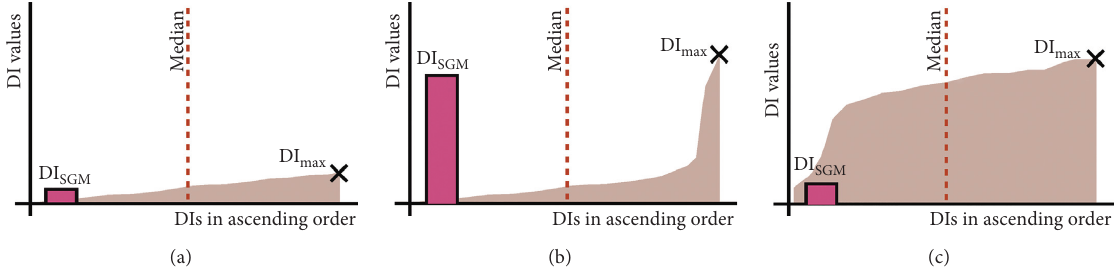
Figure 2: SGM damage index principle: (a) intact state, (b) presence of damage, and (c) environmental